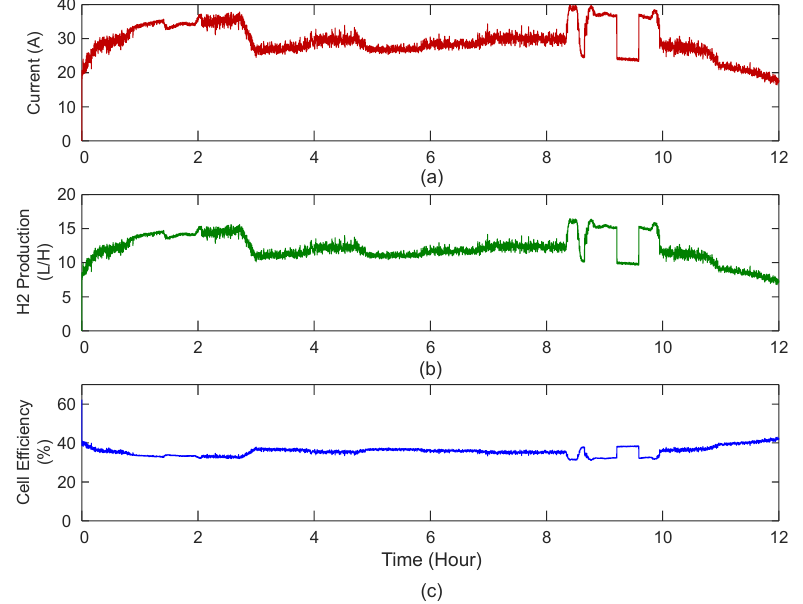
Figure 24. ( a ) Current drawn by the cell during 12 h of operation, ( b ) hydrogen production and ( c ) corresponding cell efficiency for the